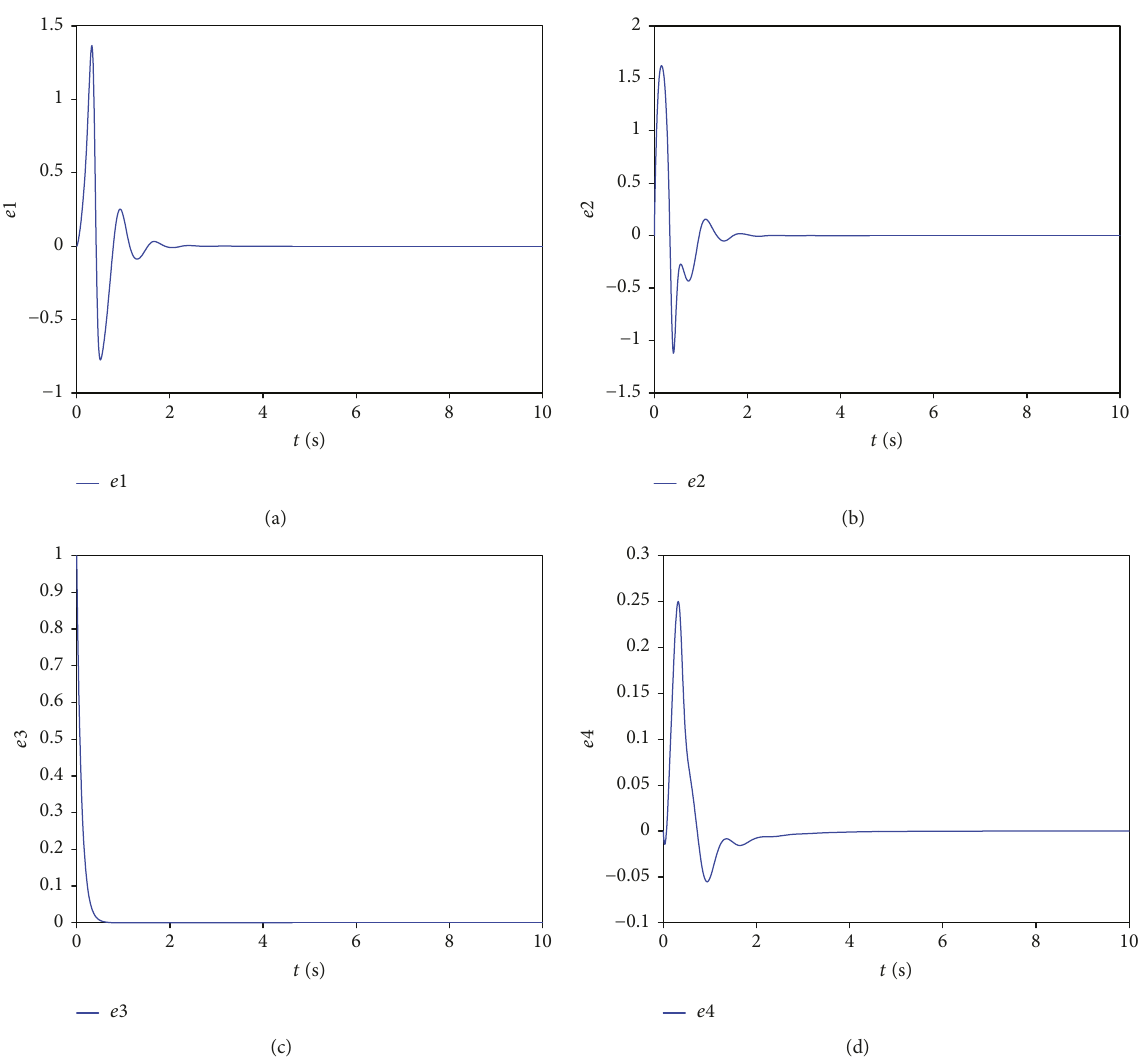
. (b) State trajectories of e 1